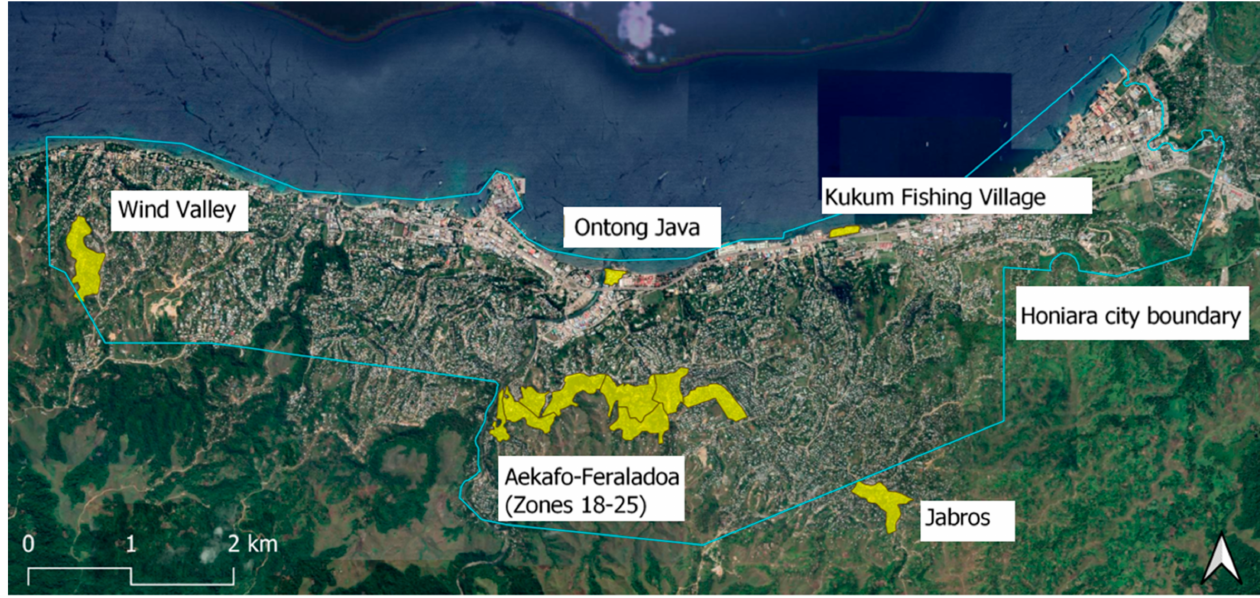
Figure 1. Honiara map of informal settlements (author-generated using data from Google Earth and Ministry of Lands, Housing and